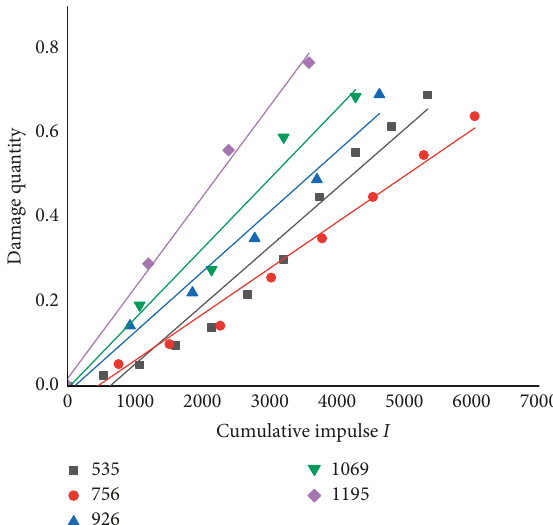
Figure 15: Relationship between damage quantity at different levels of impulse and cumulative impulse.